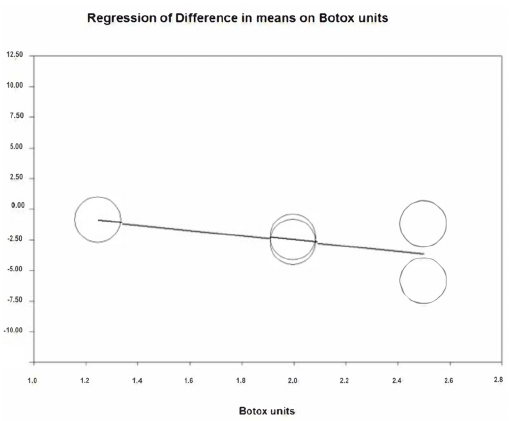
Figure 4. Reduction in gummy smile at three months.